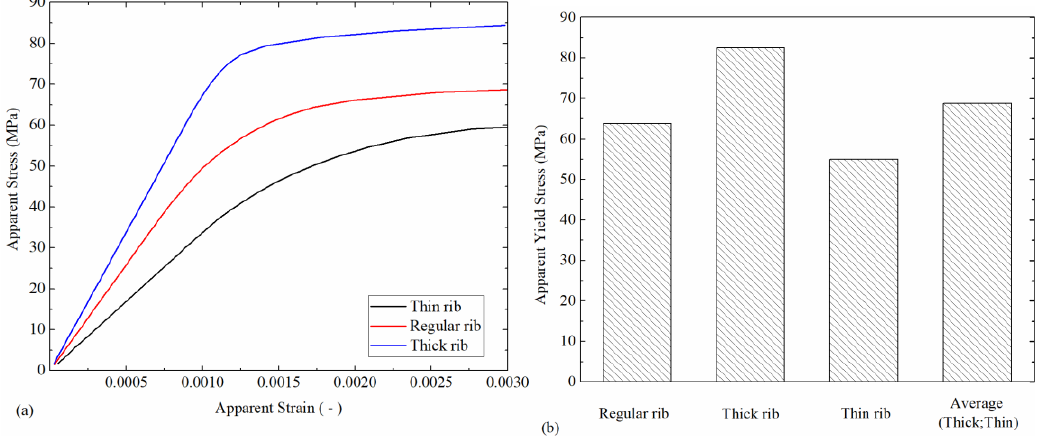
Figure 11. FEA results: ( a ) model apparent stress strain curves; and ( b ) apparent yield strength.